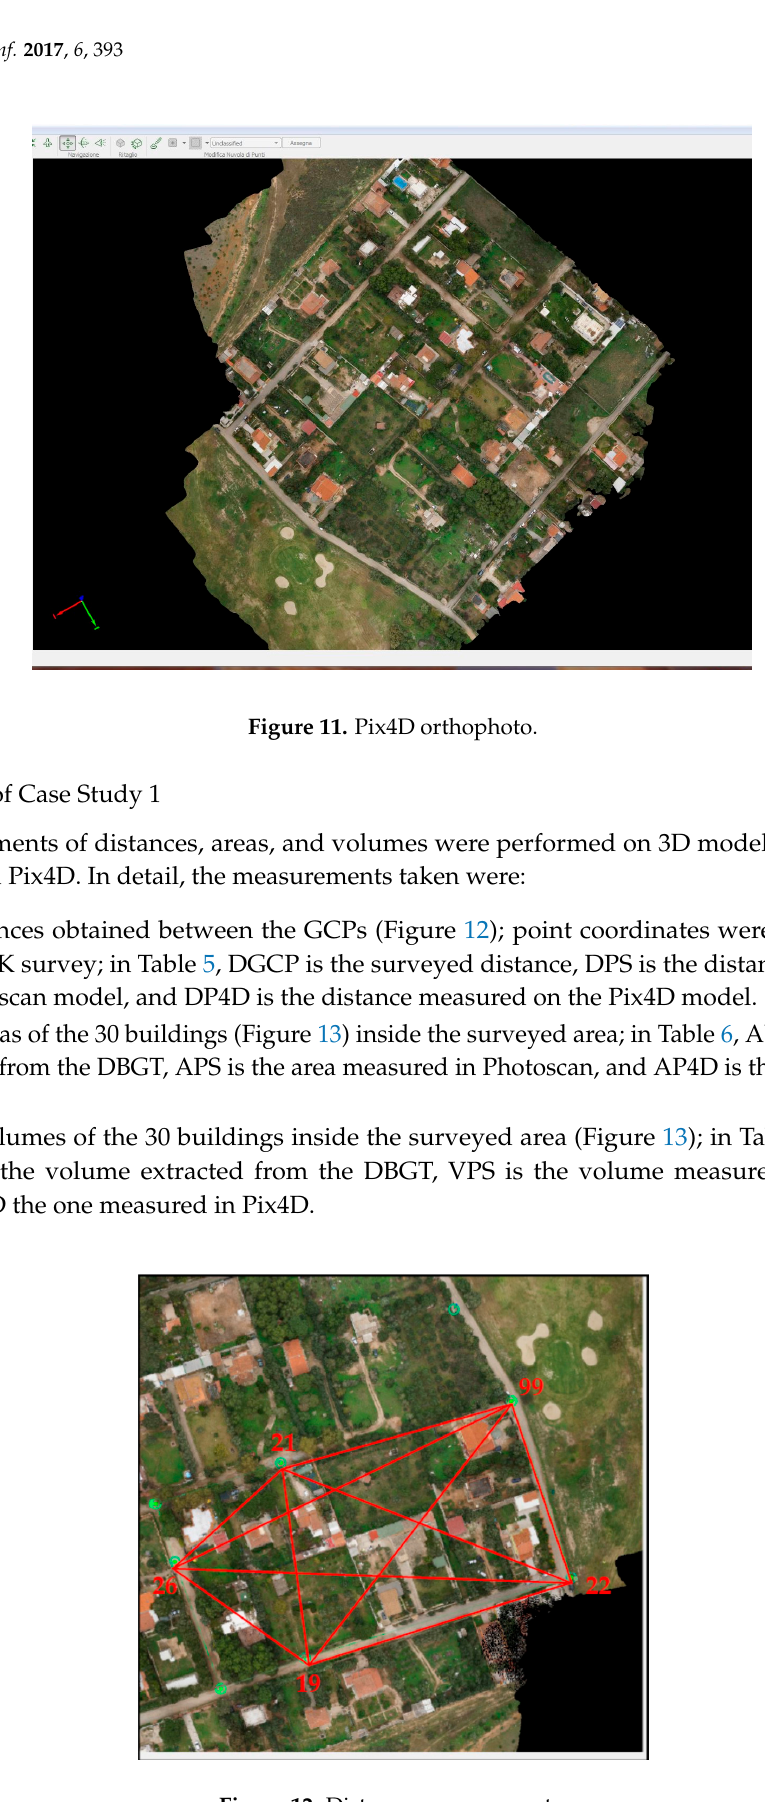
Figure 10. Pix4D raster DSM.